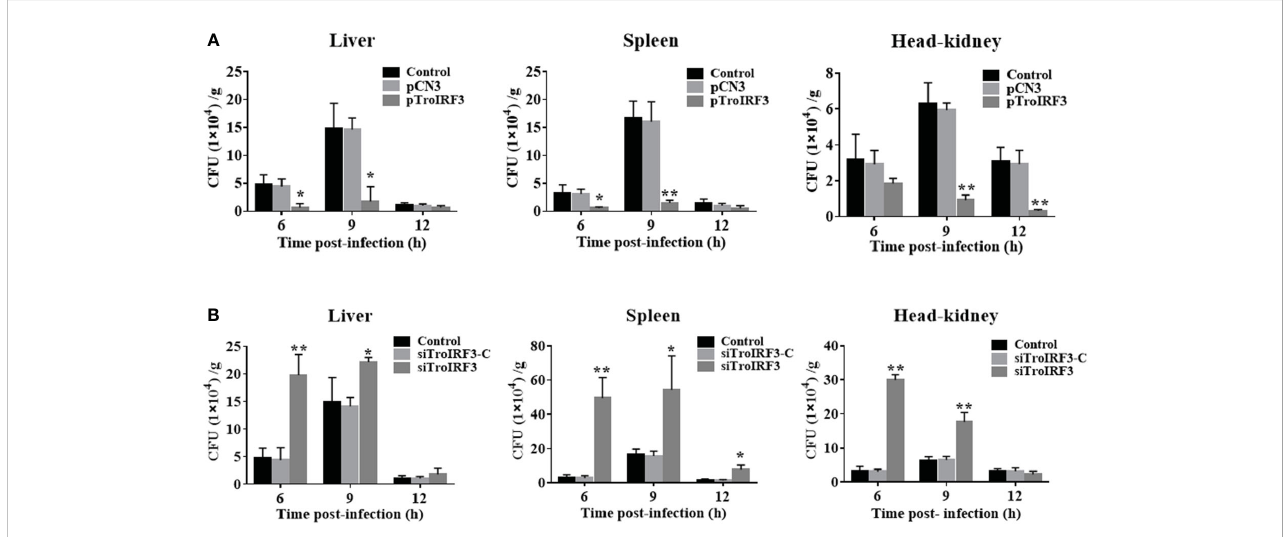
FIGURE 3 Effects of TroIRF3 on bacterial infection. (A) At fi ve days after injection with PBS (Control), pCN3, and pTroIRF3, T. ovatus was infected with V. harveyi , and their liver, spleen, and head-kidney bacteria were determined at 6, 12, and 24 hpi. (B) T. ovatus was injected with siTroIRF3, siTroIRF3-C, or PBS (Control) for 12 h, then infected with V. harveyi , and their liver, spleen, and head-kidney bacteria were determined at 6, 12, and 24 hpi. The data are shown as the means ± SD (N =3), N, the number of fi sh used at each time point per group. * P < 0.05, ** P <